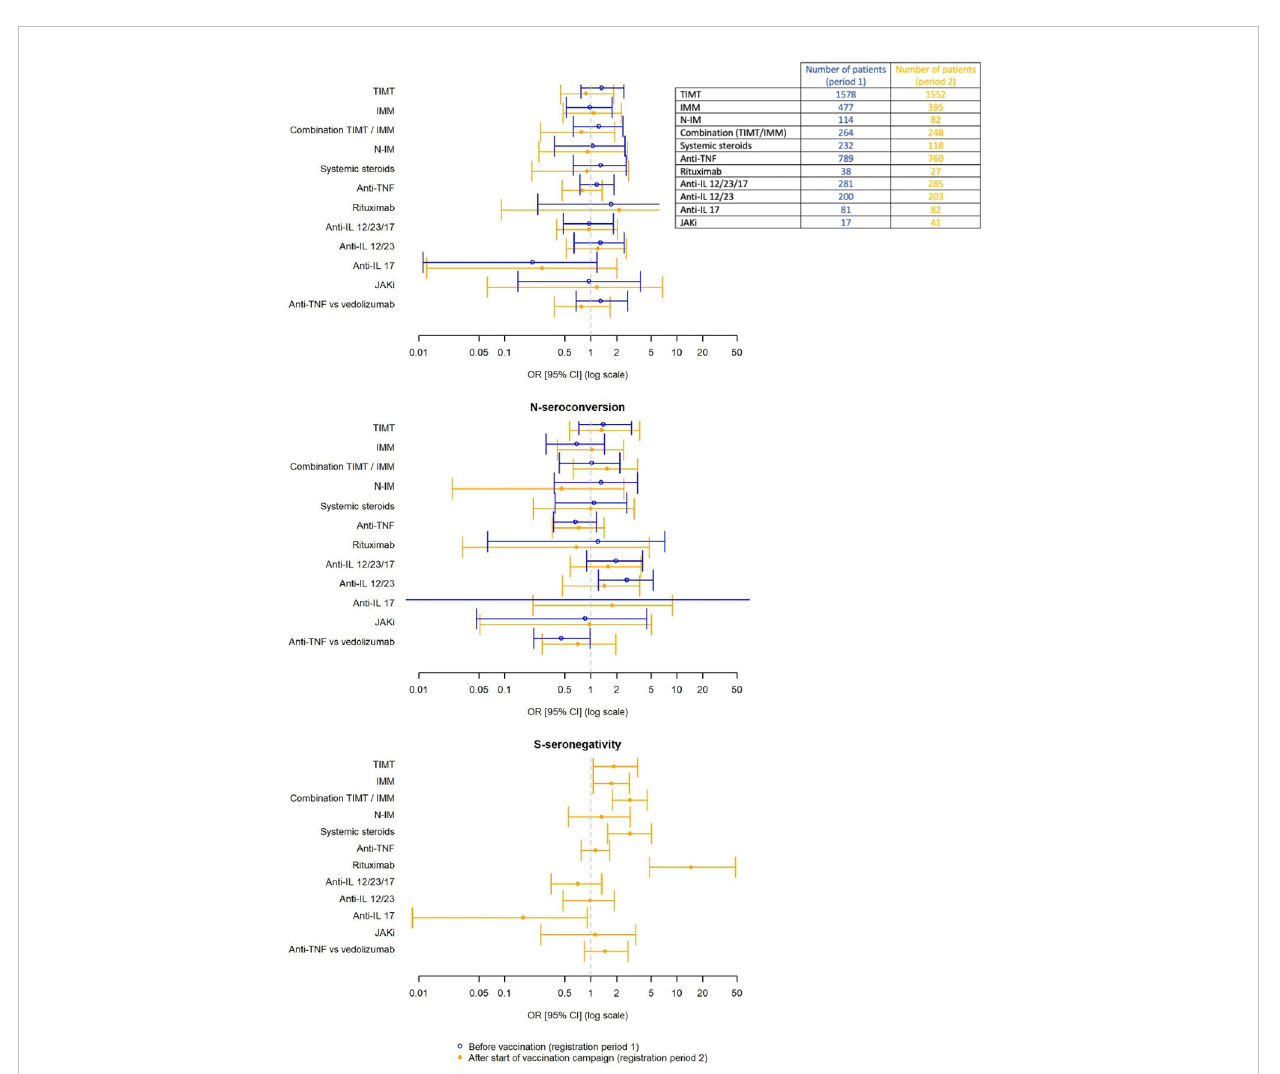
FIGURE 1 Associations between SARS-CoV-2 PCR/serology and IMID treatment